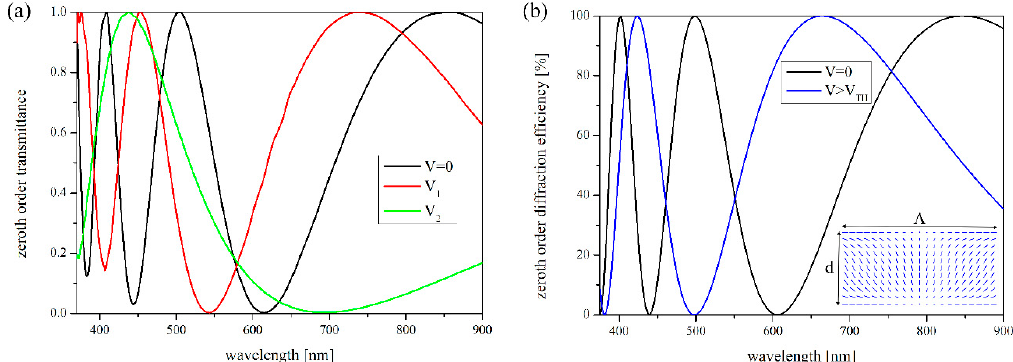
Figure 5. ( a ) Normalized zeroth-order transmittance spectra of the LC_1 grating at different voltages ( V 1 = 1.25 V and V 2 = 2.2 V) showing the effect of grating tunability in experimental conditions. ( b ) Zeroth-order diffraction efficiency calculated numerically in the grating for no-voltage and at the voltage exceeding the Fredericks threshold (V TH ) with V 1 < V < V 2 . Inset illustrates voltage-induced changes in molecular orientation in the y-z plane within one grating period.